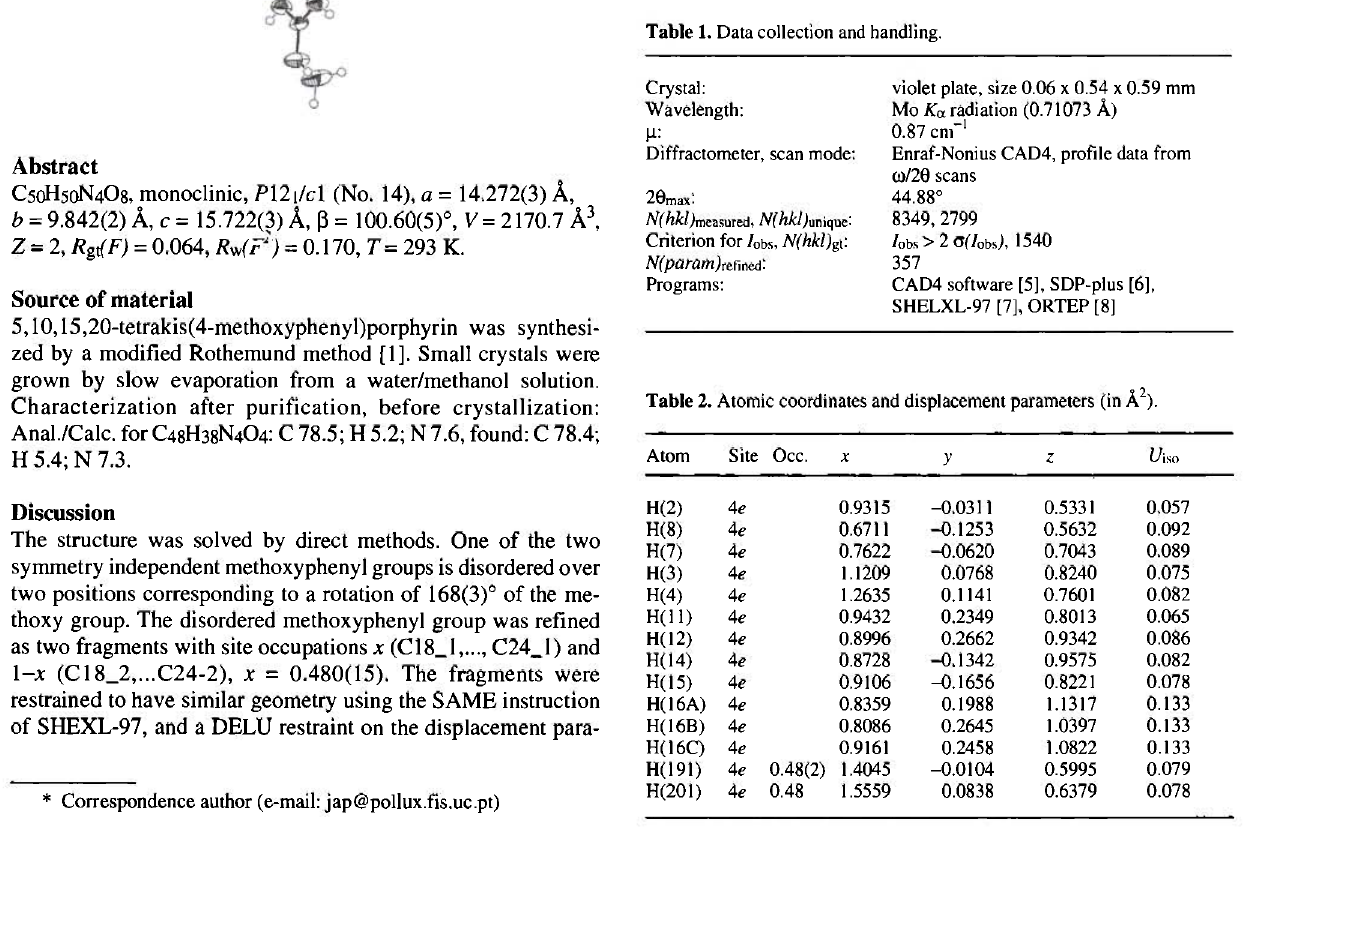
Table 1. Data collection and handling.